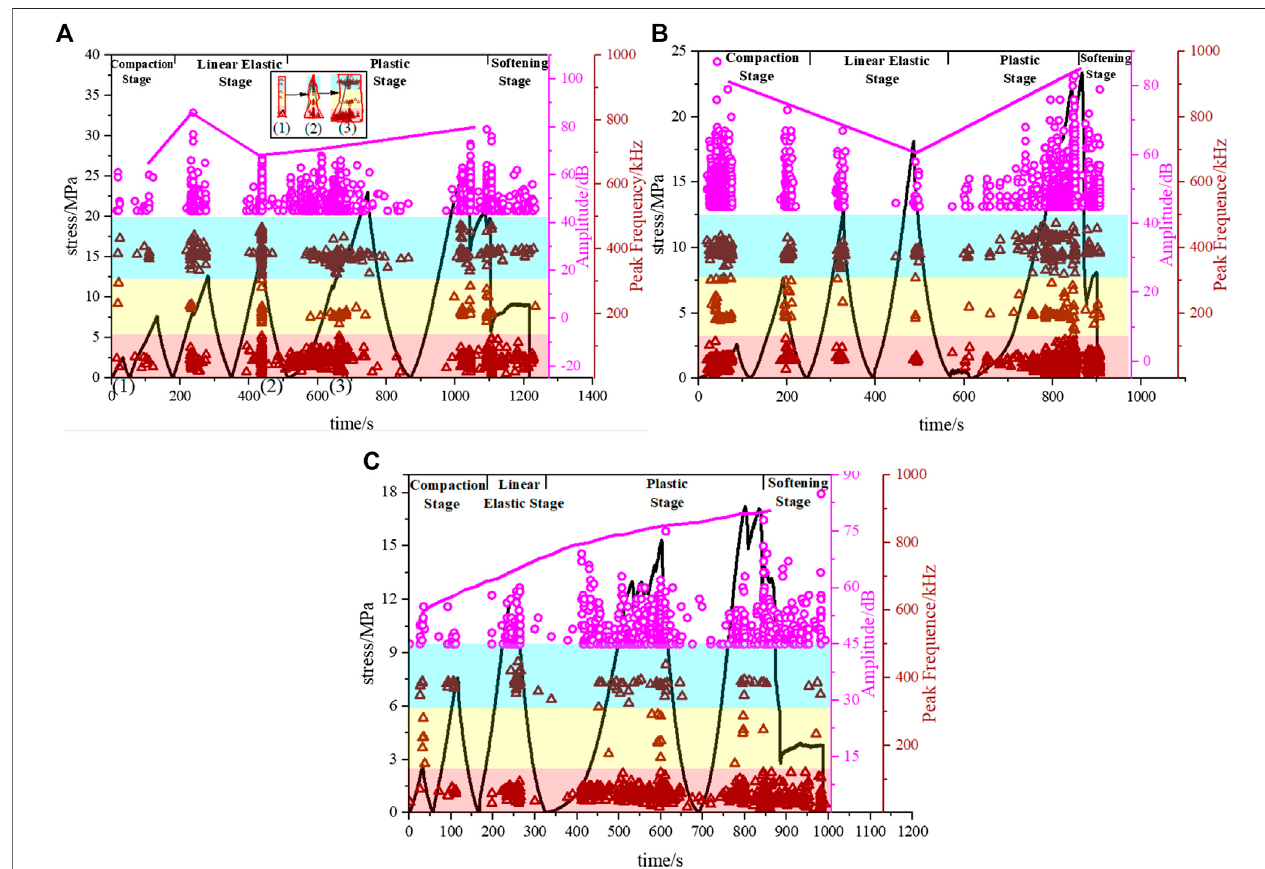
FIGURE5| Variationprocessoftheamplitudeandpeakfrequencysignalsunderdifferentloadingrates. (A) v (cid:2) 0.15 mm/min; (B) v (cid:2) 0.2 mm/min; (C) v (cid:2) 0.3 mm/ min.